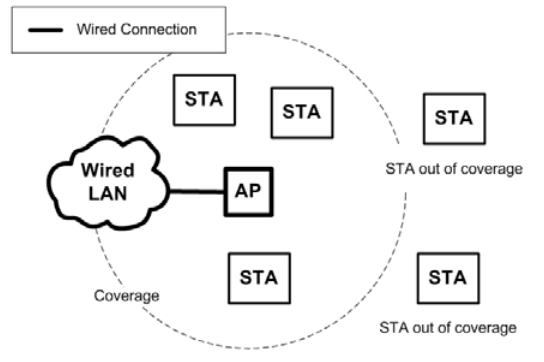
Figure 1. A basic wireless local area network